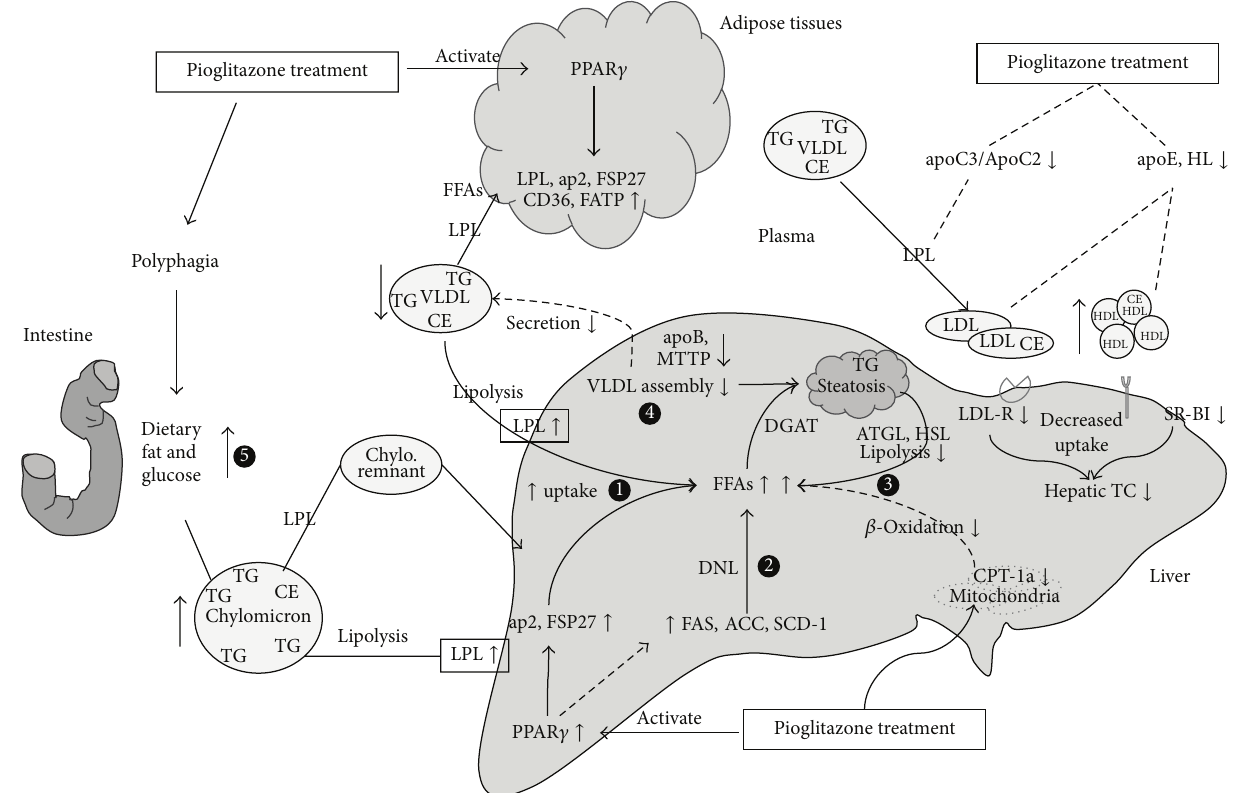
Figure 6: Schematic diagram for the potential mechanisms of pioglitazone exacerbation of hepatic steatosis and increased plasma cholesterol inKKAymice.Pioglitazoneinducedhepaticsteatosismaybemediatedby(1)increaseduptakeofFFAsfromplasmatoliverthroughpromoting FFA transporter (LPL, ap2); (2) enhanced de novo lipogenesis (DNL) in the liver (FAS, ACC, SCD-1); (3) decreased TGs lipolysis and FFAs 𝛽 -oxidation (HSL, CPT-1a); (4) impaired secretion of lipoprotein (VLDL) into plasma (apoB, MTTP); (5) increased dietary fat absorption. Furthermore, pioglitazone may suppress the clearance of serum cholesterol from the liver predominantly through inhibiting LDL-R and SR-BI expression, thus increasing the plasma levels of